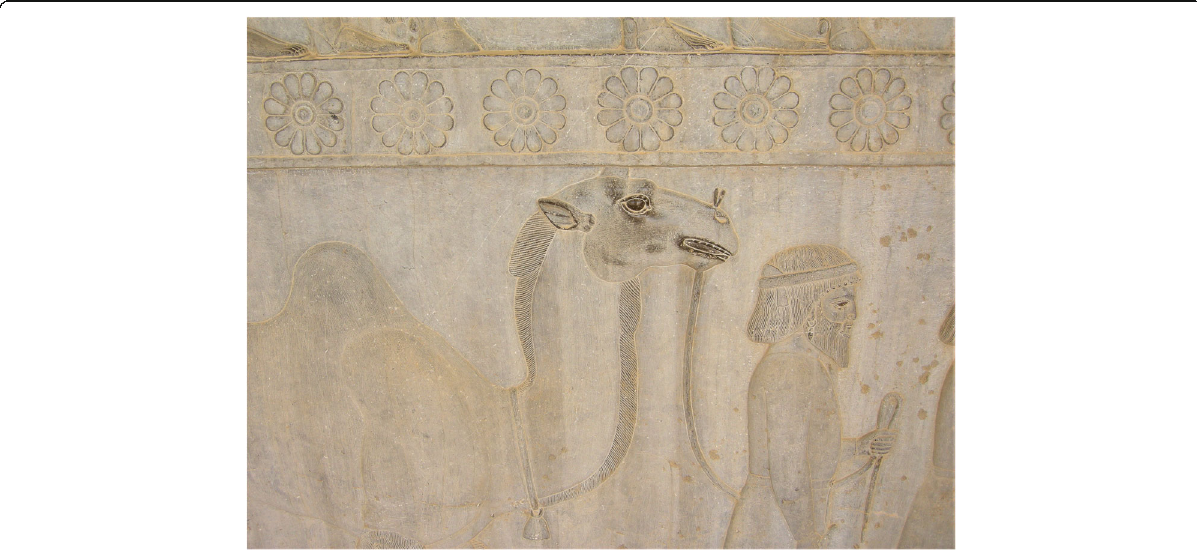
Fig. 5 A bassrelief from the audience hall of Persepolis showing a Bactrian camel being offered as a gift to the Persian king (c. 515 B.C.). Note the use of a nose peg to lead the animal (Dioli